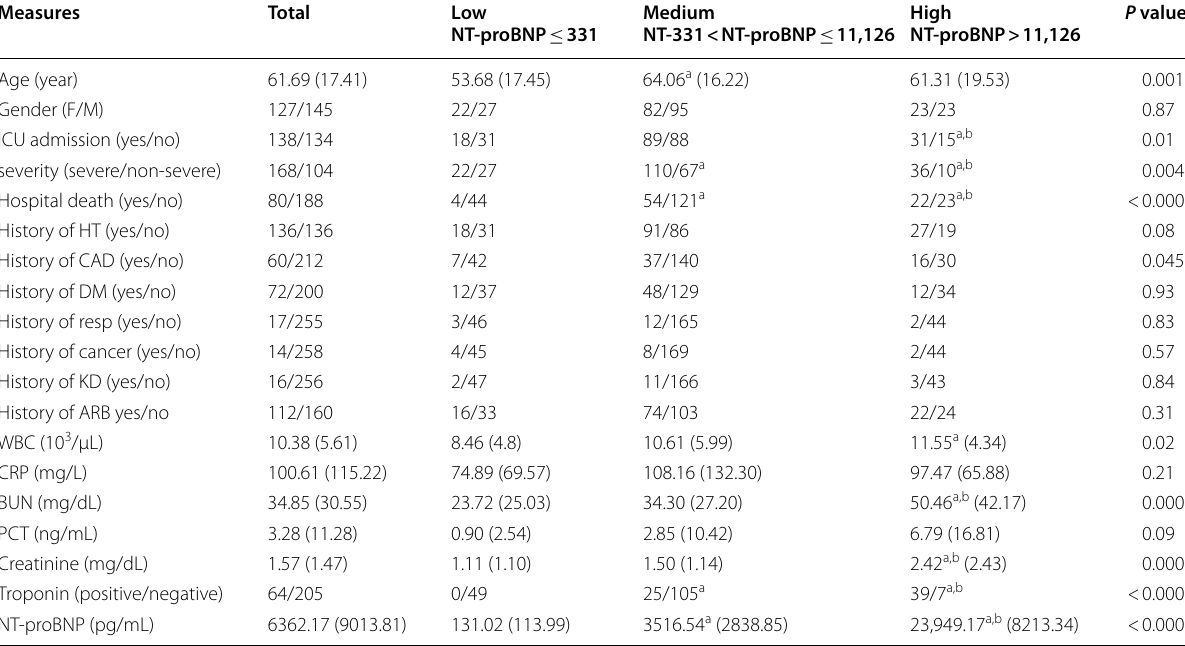
Table 1 Baseline measurements of included patients with COVID-19 according to level of